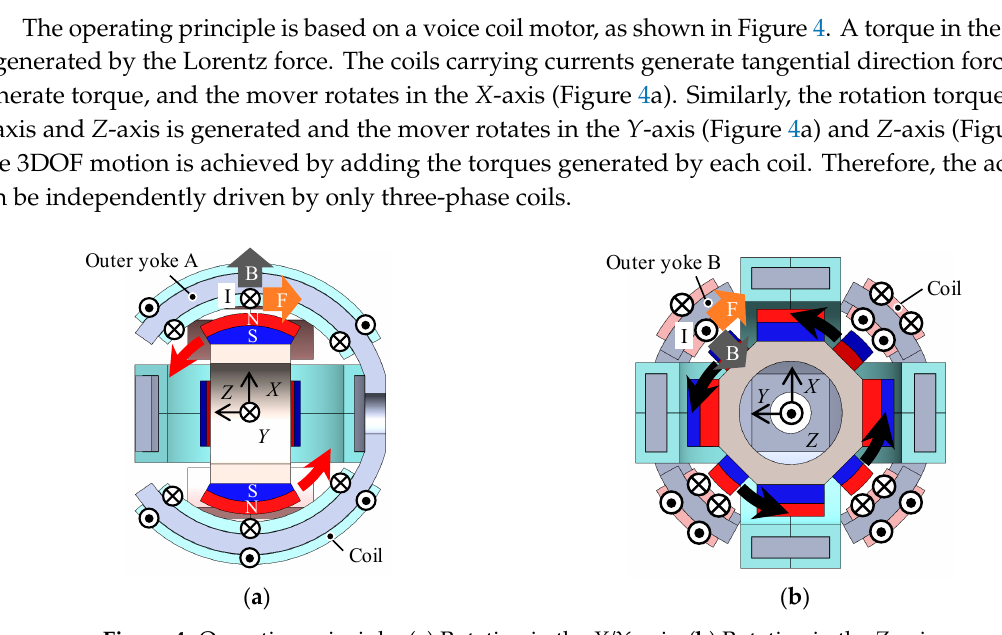
Figure 4. Operating principle. ( a ) Rotation in the X / Y -axis; ( b ) Rotation in the Z -axis.